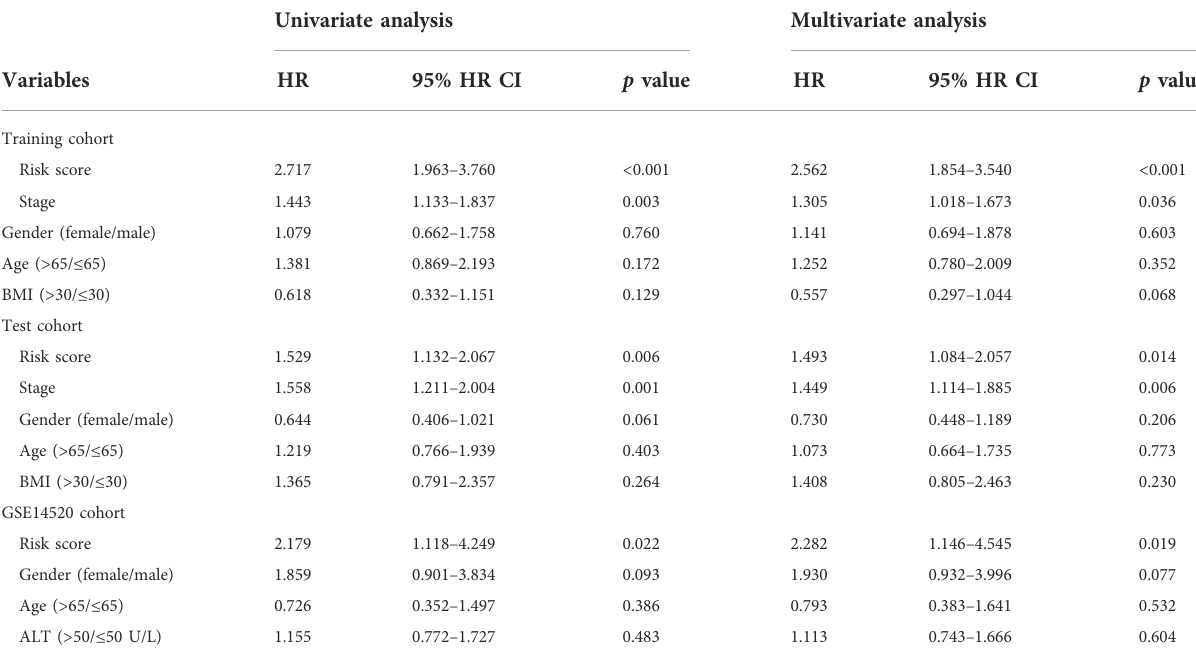
TABLE 1 Univariate Cox analysis and multivariate Cox analysis of OS in each cohort. Univariate